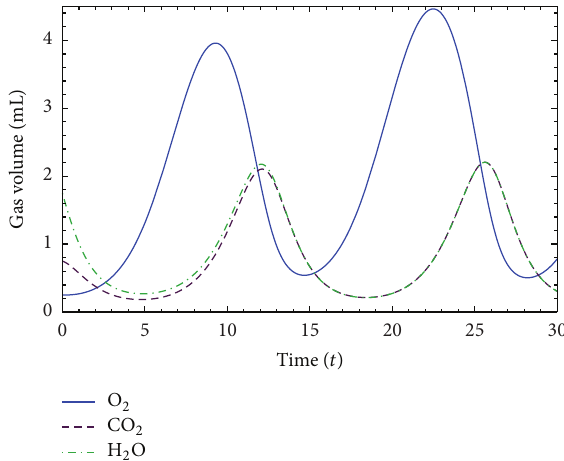
Figure 2: This figure shows the stability of equilibrium 𝐸 5 when 𝑓 < 𝑠 , which is given in Theorem 5. We choose 𝑓 = 0.5 and 𝑠 = 1 . As can be seen from the graph, the oxygen volume goes to equilibrium 𝐾 = 1.9 and the carbon dioxide and water-vapor go to equilibrium 0.